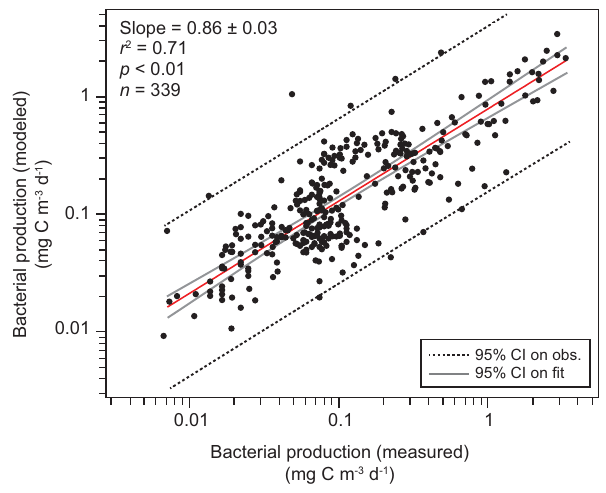
Fig. A2. Relationship between surface POC concentration and the blue-to-green ratio of remote-sensing reflectance (490, 560nm) measured during the CASES 2004 and Malina 2009 field cam- paigns. This empirical algorithm was used to produce the MERIS composites of surface POC presented in Fig. 3. Details on the col- lection and analysis of the CASES 2004 dataset can be found in Forest et al. (2010a).